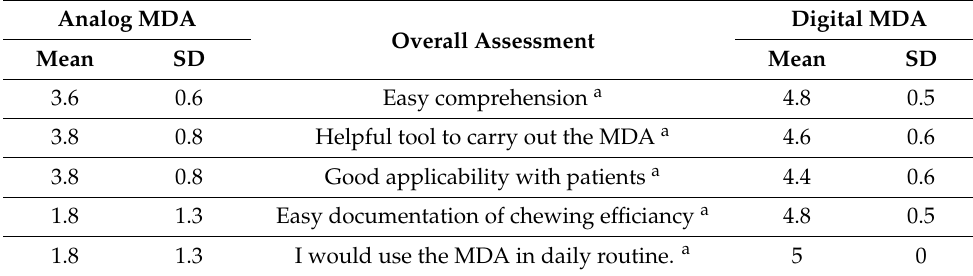
Table 7. Items and descriptive statistics of questionnaire regarding the use of analog and digital MDA answered by nurses (n =